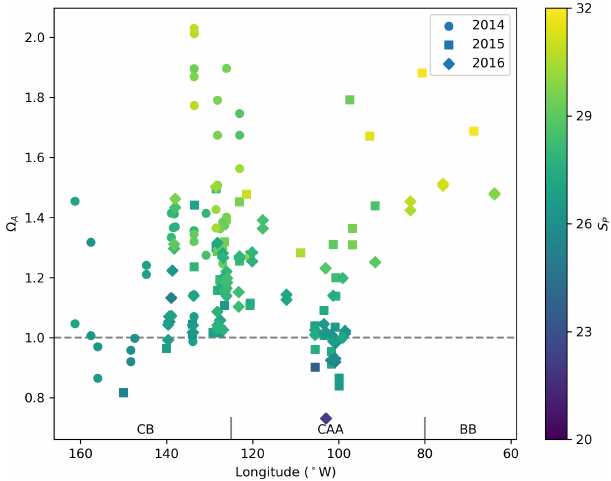
Figure 6. Surface water ( < 10m) (cid:127) A and associated practical salin- ities ( S P , colour scale) in 2014, 2015 and 2016 in the Canada Basin (CB), Canadian Arctic Archipelago (CAA) and Baffin Bay (BB). The horizontal line at (cid:127) A = 1 represents saturation with respect to